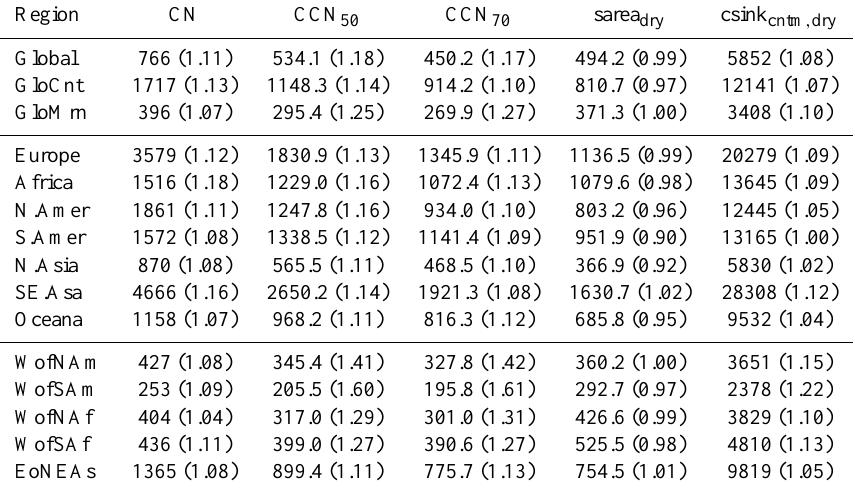
Table A2. Summary of annual-mean CN (10nm dry diameter), CCN (50nm dry diameter), CCN (70nm dry diameter), surface area density (dry) and condensation sink in the continuum region (dry) simulated by GLOMAP-mode (improved configuration) with the ratio to that simulated by GLOMAP-bin shown in parentheses. Units are cm − 3 for CN and CCN, µm 2 cm − 3 for surface area concentration and µmcm − 3 for condensation sink. Regions match those defined in Merikanto et al.